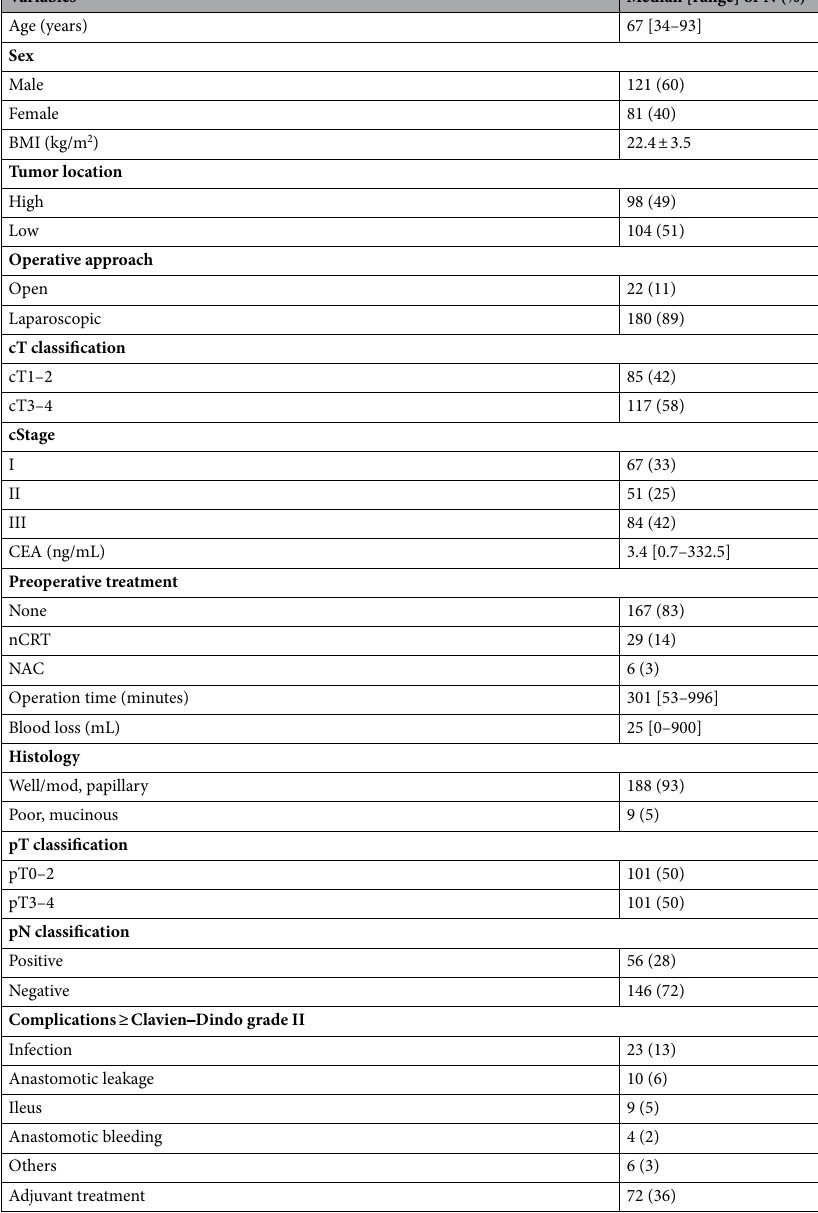
Table 1. Clinicopathological characteristics of study participants. BMI body mass index, cT clinical stage based on tumor size and spread of cancer to nearby tissue, cStage clinical stage of cancer,